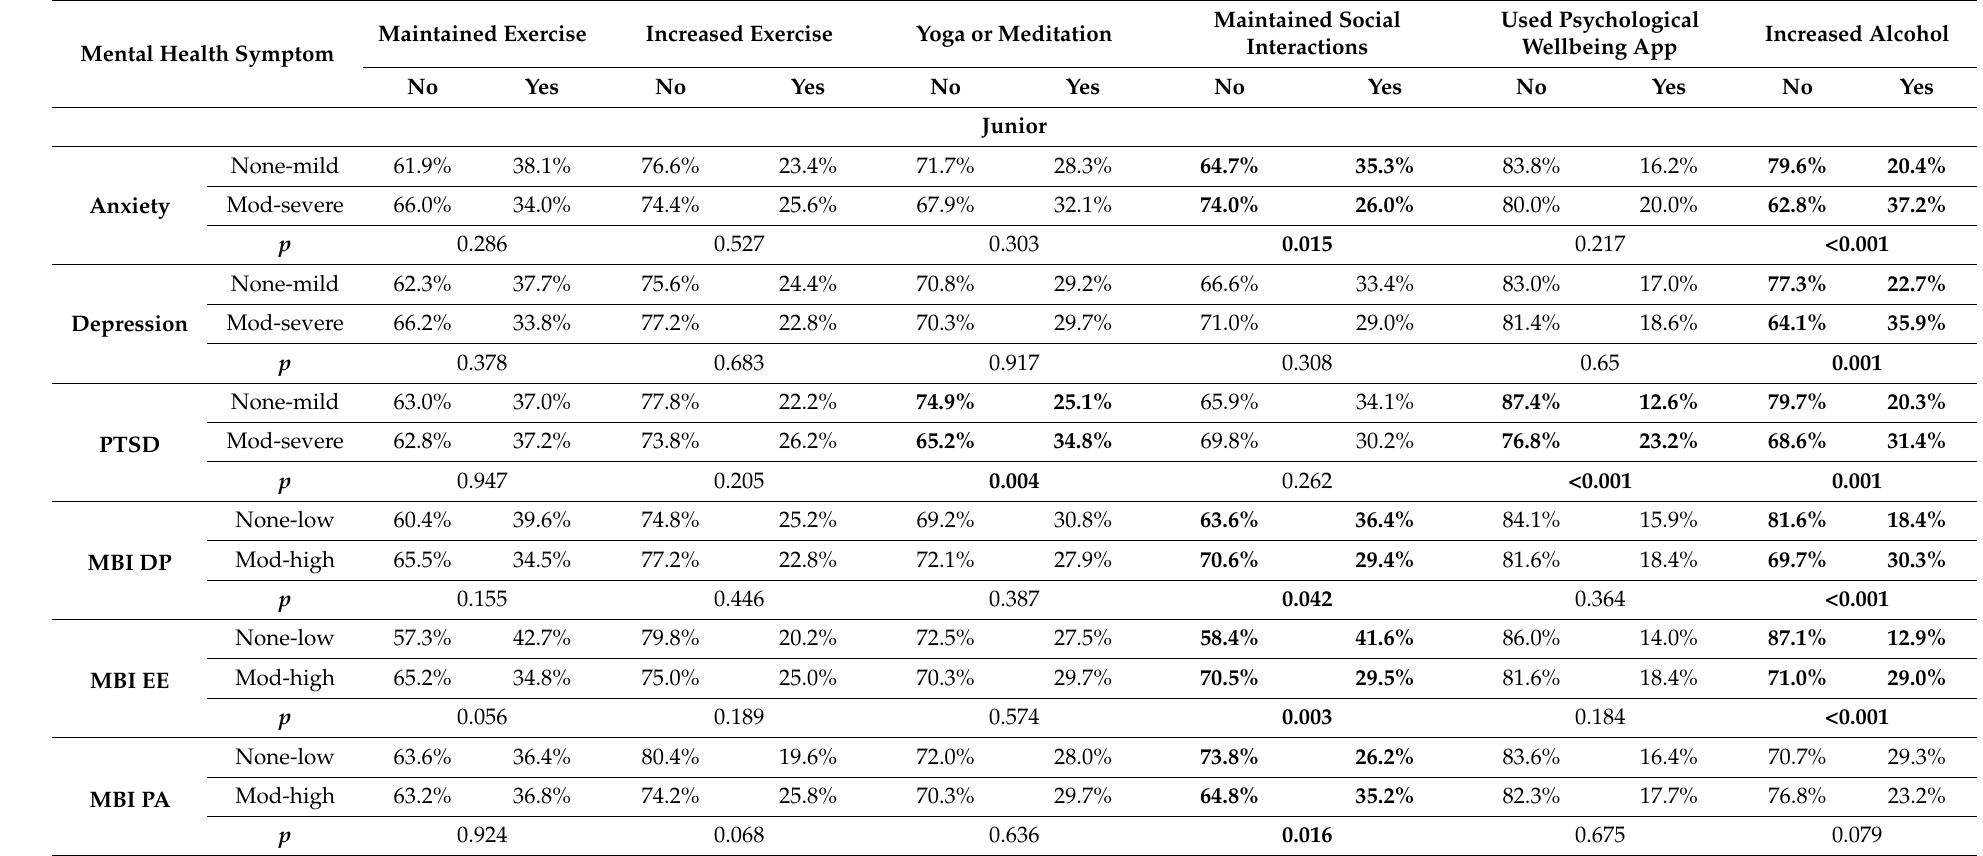
Table 3. Associations between coping strategies and mental health